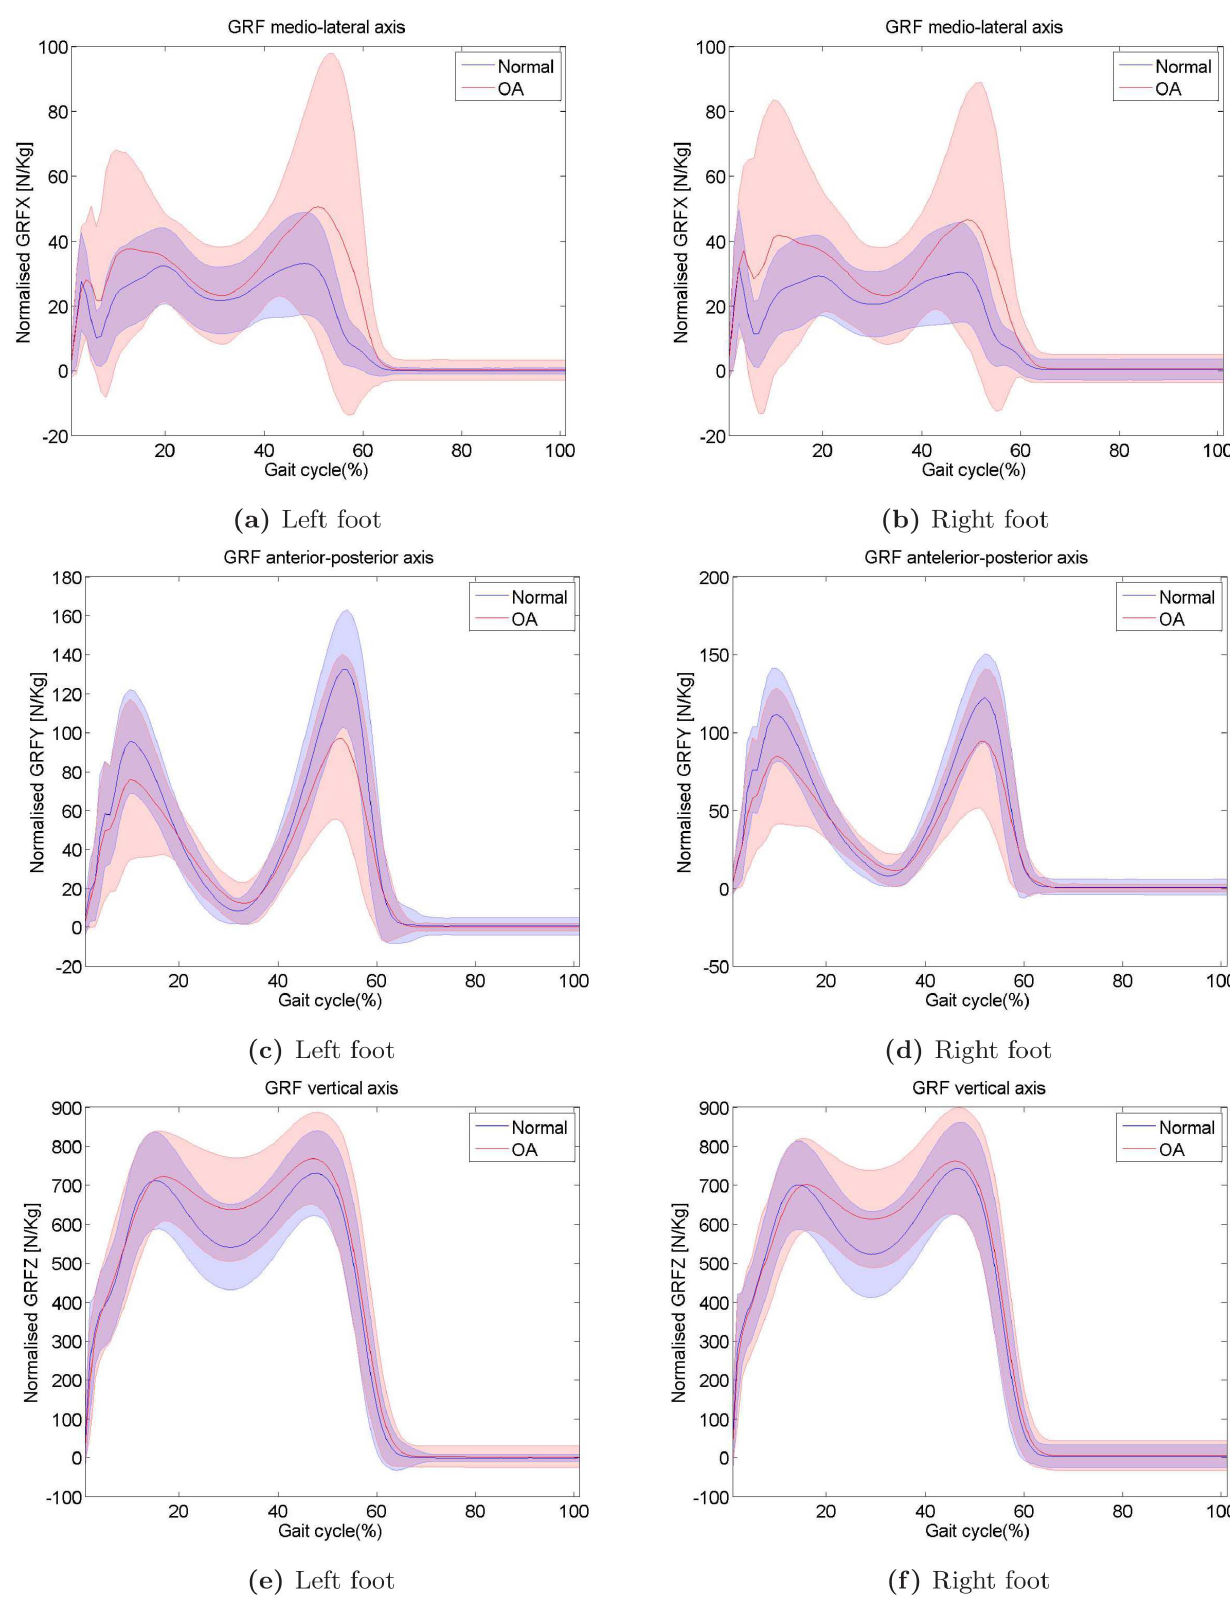
Figure 2. The blue curve corresponds to the mean GRF curve, whereas the blue shaded region indicates the precision of plus minus one standard deviation. Accordingly, the foot which has knee OA is depicted in red.